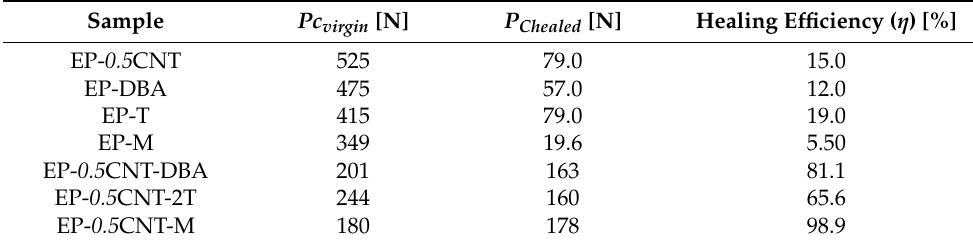
Figure 12. Load displacement curves for the samples: ( a ) EP ‐ 0.5 CNT ‐ DBA, ( b ) EP ‐ 0.5 CNT ‐ T and ( c ) EP ‐ 0.5 CNT ‐ M and ( d ) histogram reporting the healing efficiency values for the tested samples. Table 3. Data of the healing efficiency tests of the tested samples.